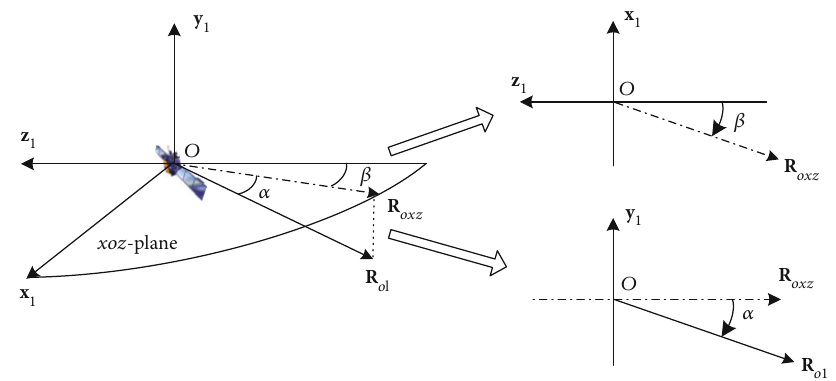
Figure 8: The installation angles of optical sensor.